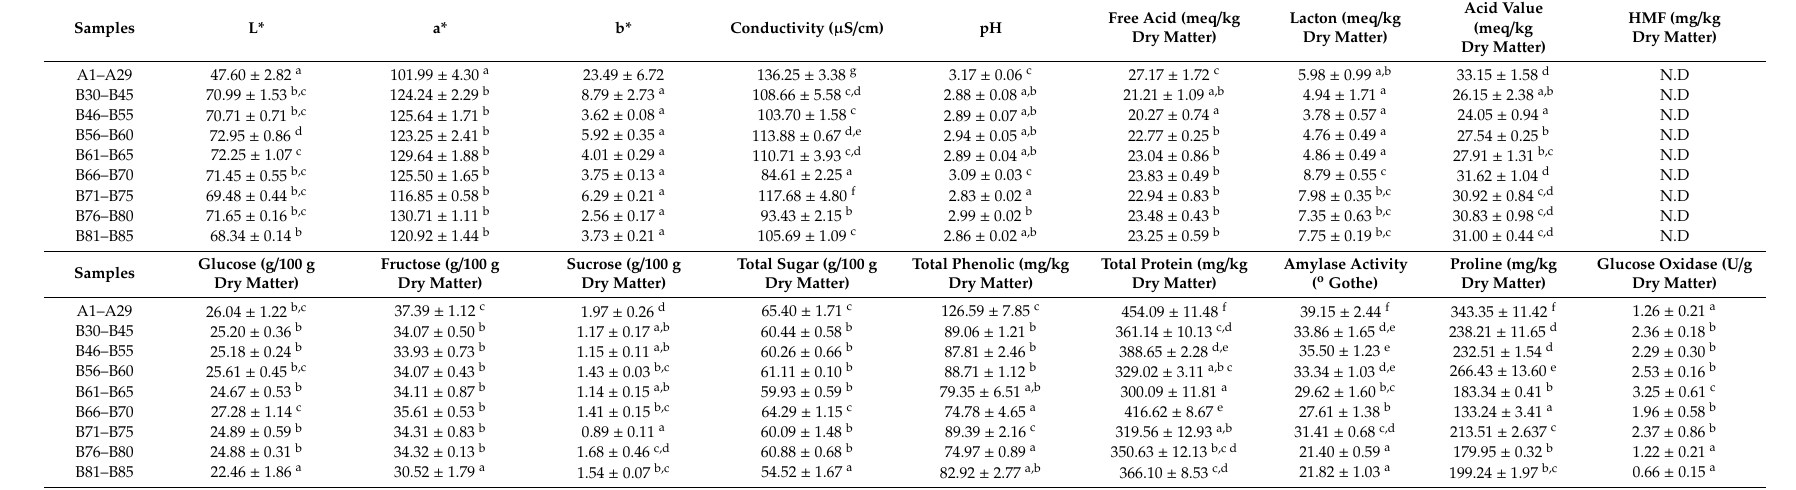
Table 2. Physicochemical property of samples (dry-weight